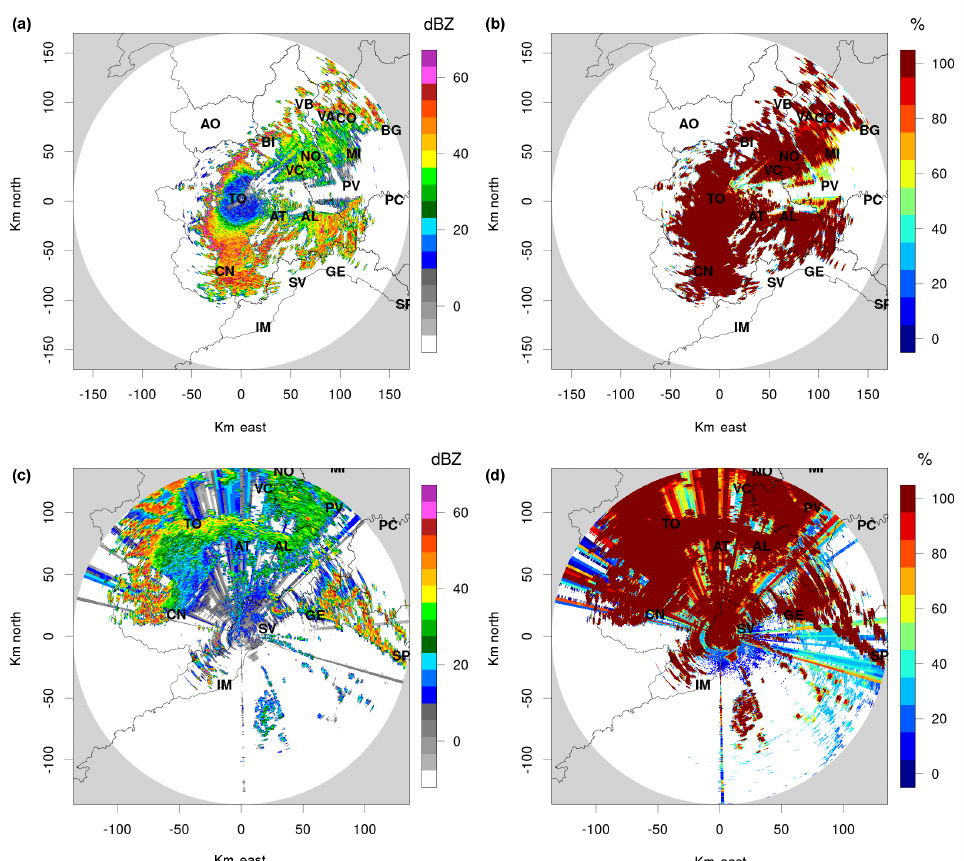
Figure 3. Mean reflectivity value and frequency of clutter echoes collected by the Bric della Croce (figures a and b ) and by Monte Settepani (figures c and d ) radars at the lowest elevations: − 0 . 1 and − 0 . 3 ◦ , respectively. The maximum value exceeds 64dBZ, and 100% represents very stable